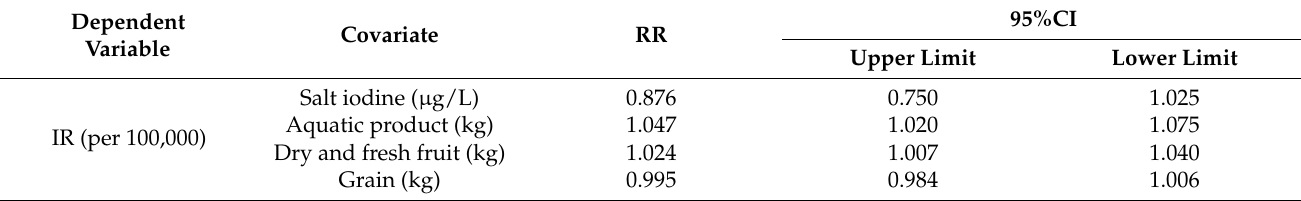
Table 6. Generalized linear model